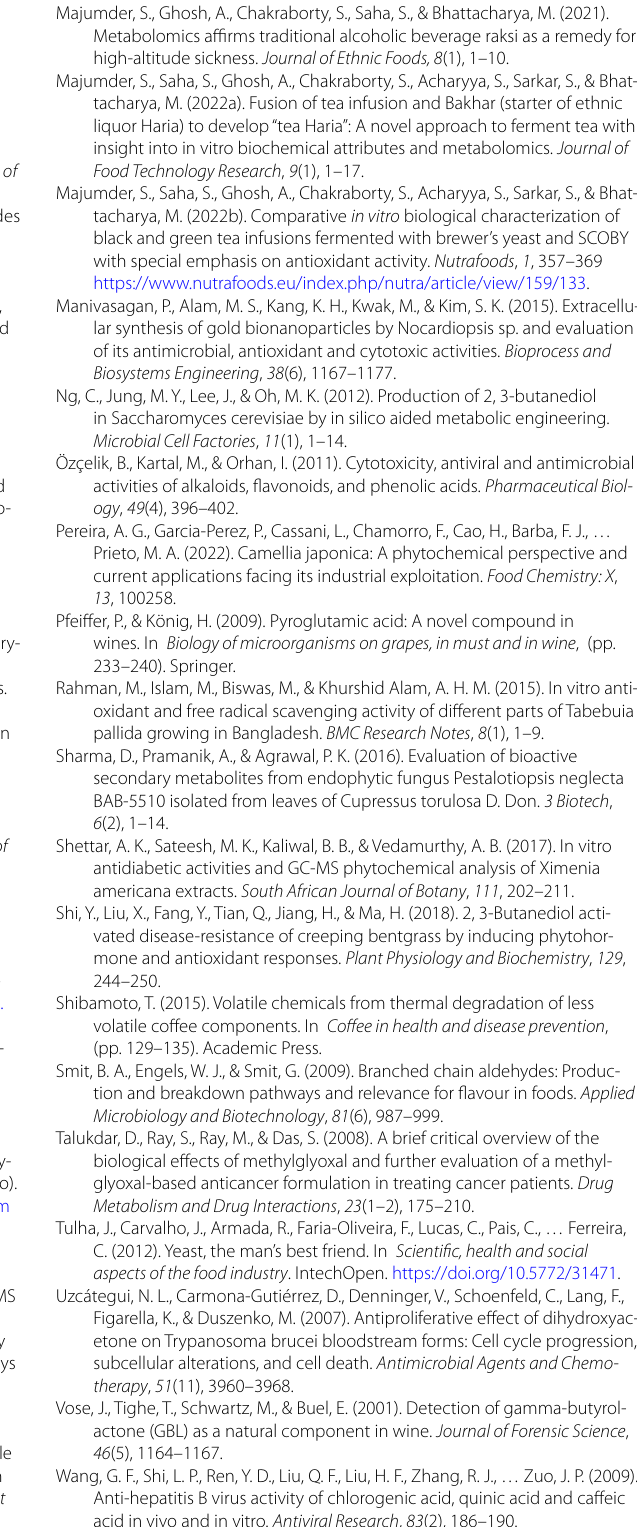
Figarella, K., & Duszenko, M. (2007). Antiproliferative effect of dihydroxyac- etone on Trypanosoma brucei bloodstream forms: Cell cycle